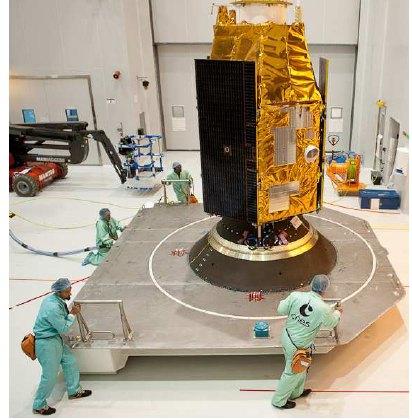
Figure 2: Pleiades 1A a few days before launch